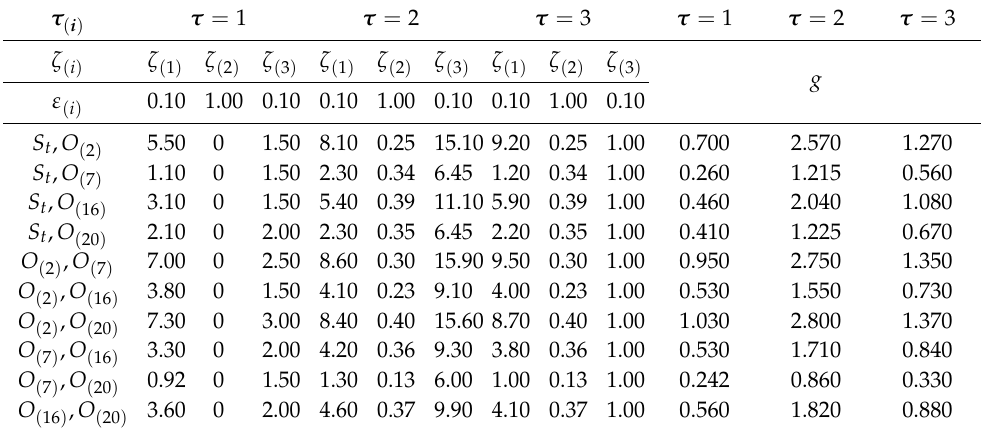
portation modes τ ( R to ( i ) , R to ( j ) )